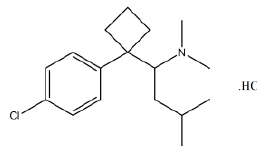
Figure1. Chemical structure of sibutramine